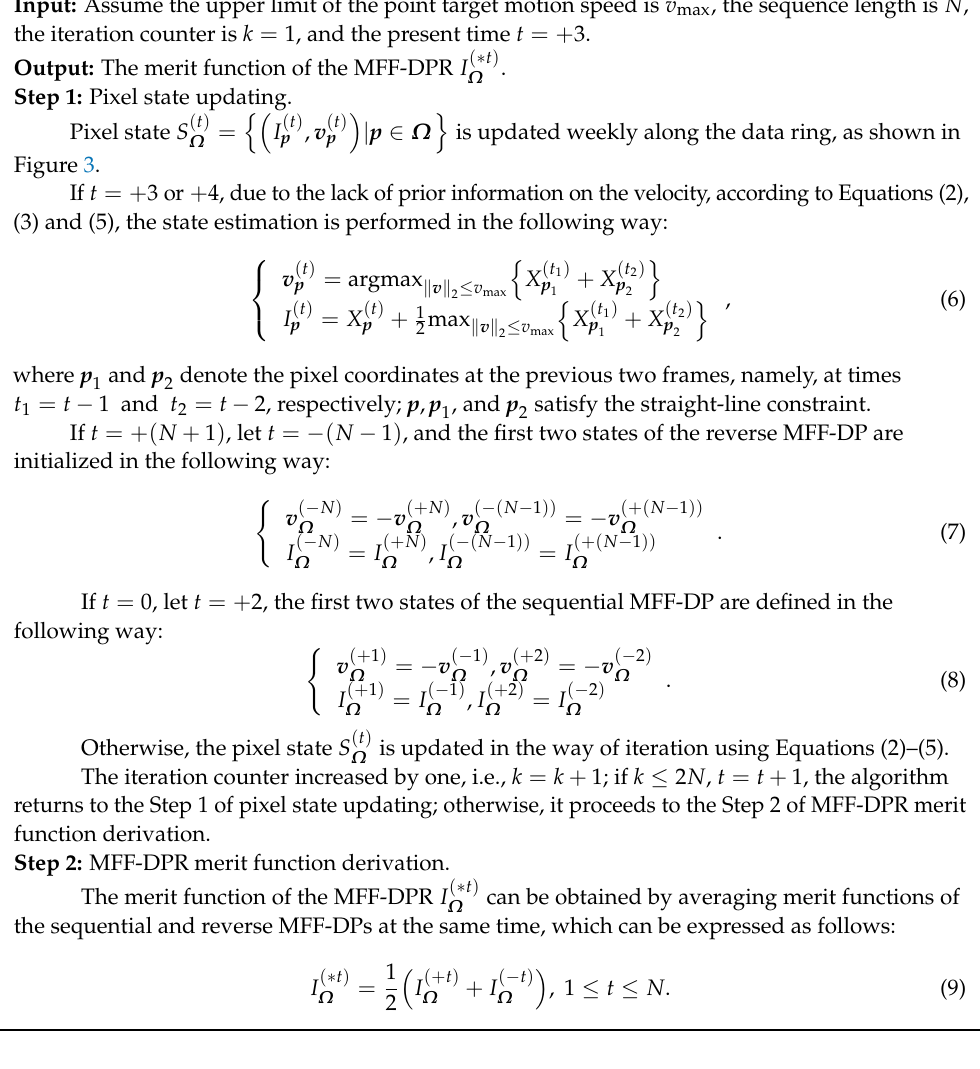
Figure 3. Sketchy diagram of the DPR; 𝑆 𝜴(+𝑡) and 𝑆 𝜴(−𝑡) denote the pixel state estimation results of the sequential and reverse DPs at time 𝑡 , respectively. Algorithm 1 MFF-DPR